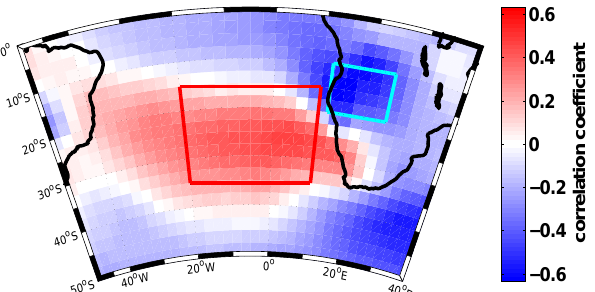
Figure 1. Correlation pattern of the sea level pressure field of NCEP/NCAR reanalysis and upwelling index of North Benguela of the STORM simulation in austral winter (JJA). The boxes indi- cate the regions used for calculating the sea level pressure difference between ocean (red) and land (cyan) in the period